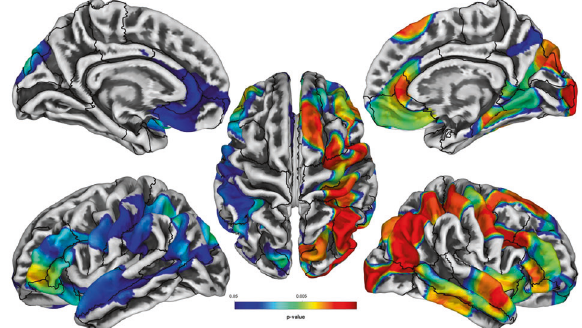
Fig. 1 Group-wise nonparametric analyses of FD using surface- based morphometry comparing PTSD negative to PTSD positive responders. Regions lacking signi fi cant differences in FD between groups are shown in gray while statistically signi fi cant results are shown using a rainbow colormap ranging from blue to red. Figure generated using Computational Anatomy Toolbox (CAT12) with superimposed Desikan – Killiany (DK) atlas regions shown in black borders.